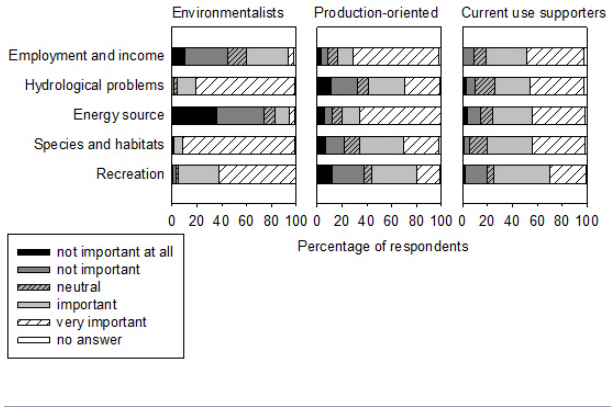
Fig. 3 . Opinions considering the ecosystem services of peatlands in the three classes of respondents, significant in the latent class model (LCM). Number of respondents =